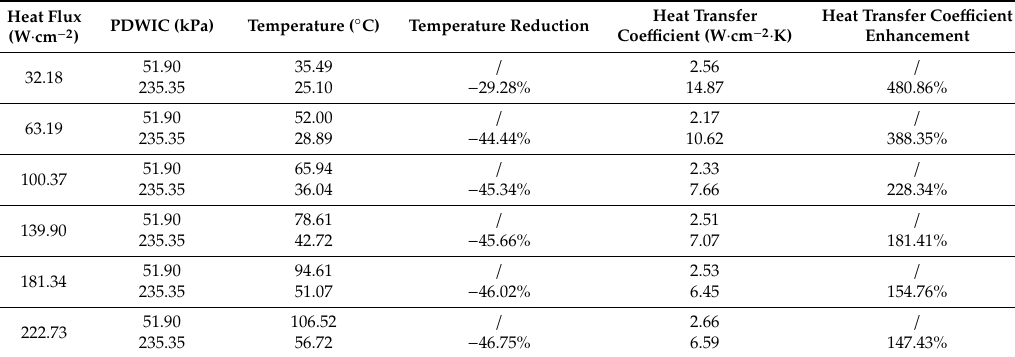
Table 4. Comparisons of the thermal